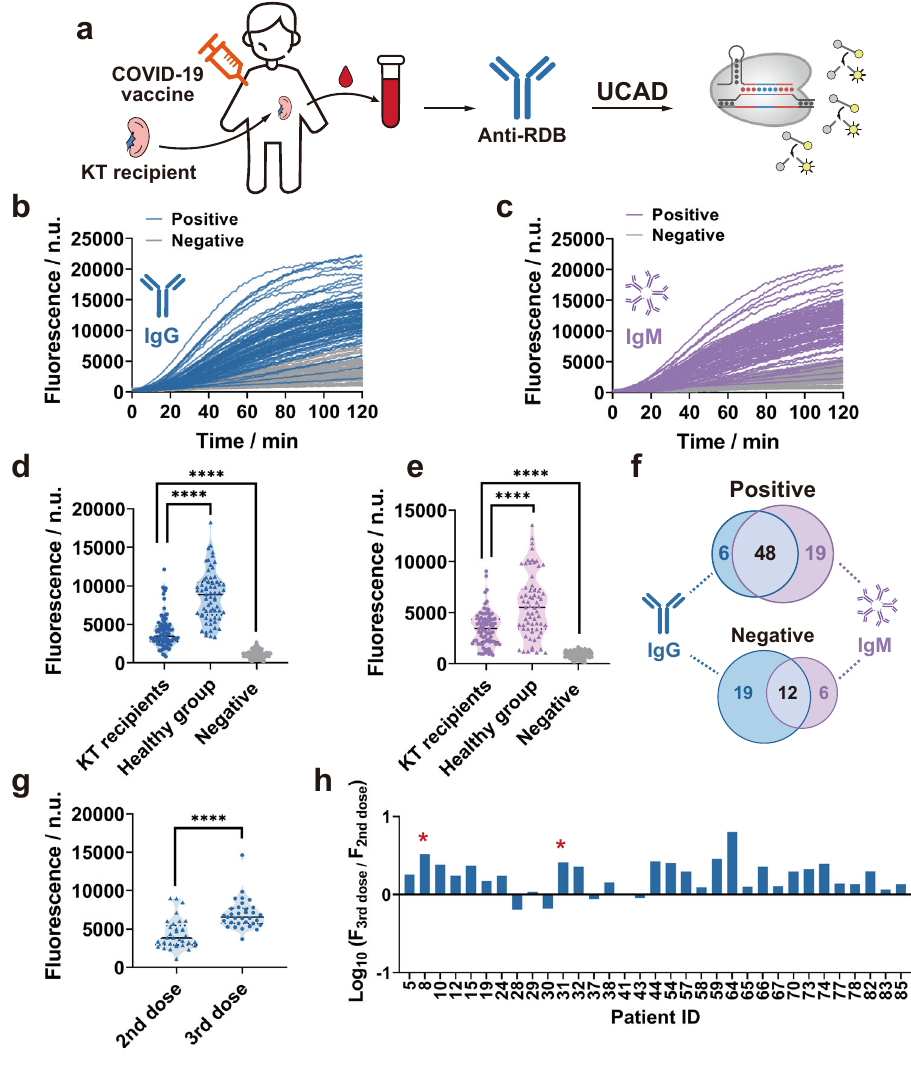
Fig. 4 | Detection of anti-RBD IgG/IgM in vaccinated KTRs using UCAD. a Schematic illustration of the UCAD work fl ow for analyzing the levels of anti-RBD IgG and IgM in clinical serum samples collected from KTR patients who had received atriad immunosuppressionregimenandtwodosesofinactivatedCOVID- 19 vaccine. b , c Kinetic curves for the detection of anti-RBD IgG ( b ) and IgM ( c ) in sera of 85 KTRs. d , e Violin plots of endpoint fl uorescence signals at 40min for detecting anti-RBD IgG ( d , p =1.76e − 12 between KTRs and healthy, p =2.64e − 19 between KTRs and negatives) and IgM ( e , p =1.96e − 7 between KTRs and healthy, p =4.18e − 23 betweenKTRsandnegatives)in85seracollectedfromKTRs,65positive seracollectedfromvaccinatedhealthyindividuals,and132negativesera.Thelevels of both anti-RBD IgG and IgM in the KTR cohort were signi fi cantly different from those in the healthy and negative cohorts. Unpaired two-tailed t -tests were